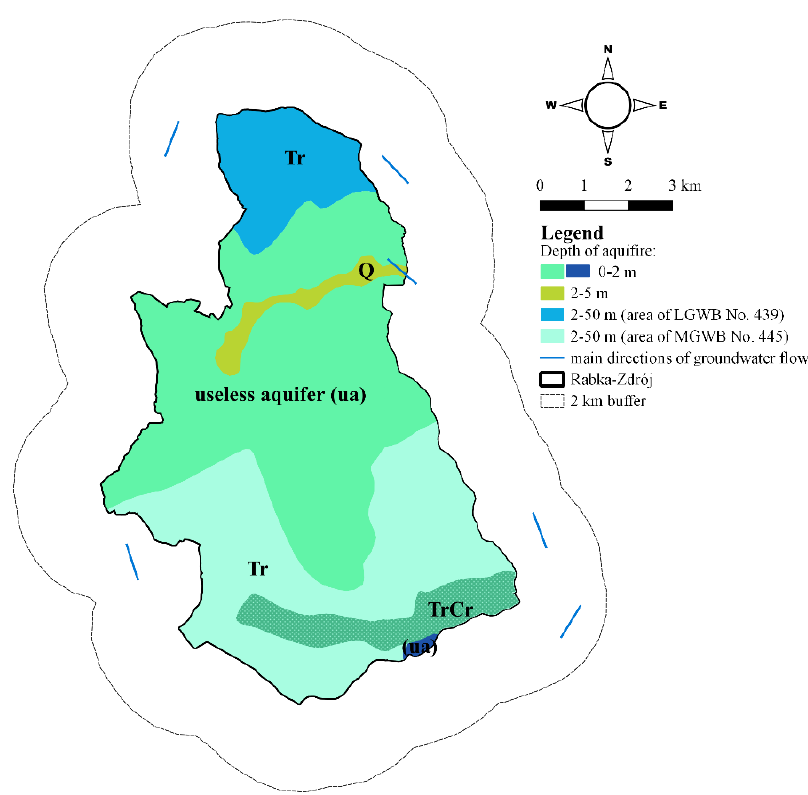
Figure 4. Hydrogeological map of the Rabka-Zdrój area, based on [41,42].